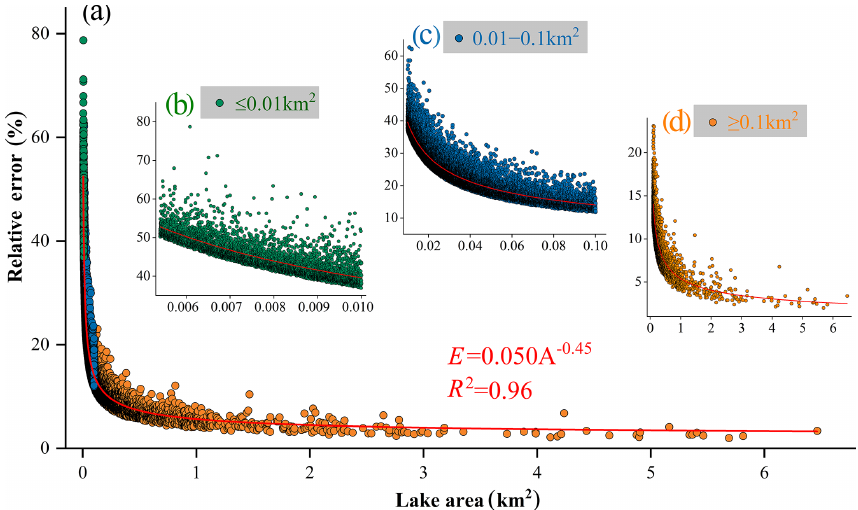
Figure 5. Relationships of relative area error against size of glacial lakes in HMA: (a) relationship for glacial lakes of all sizes and (b–d) relationships for glacial lakes of specific